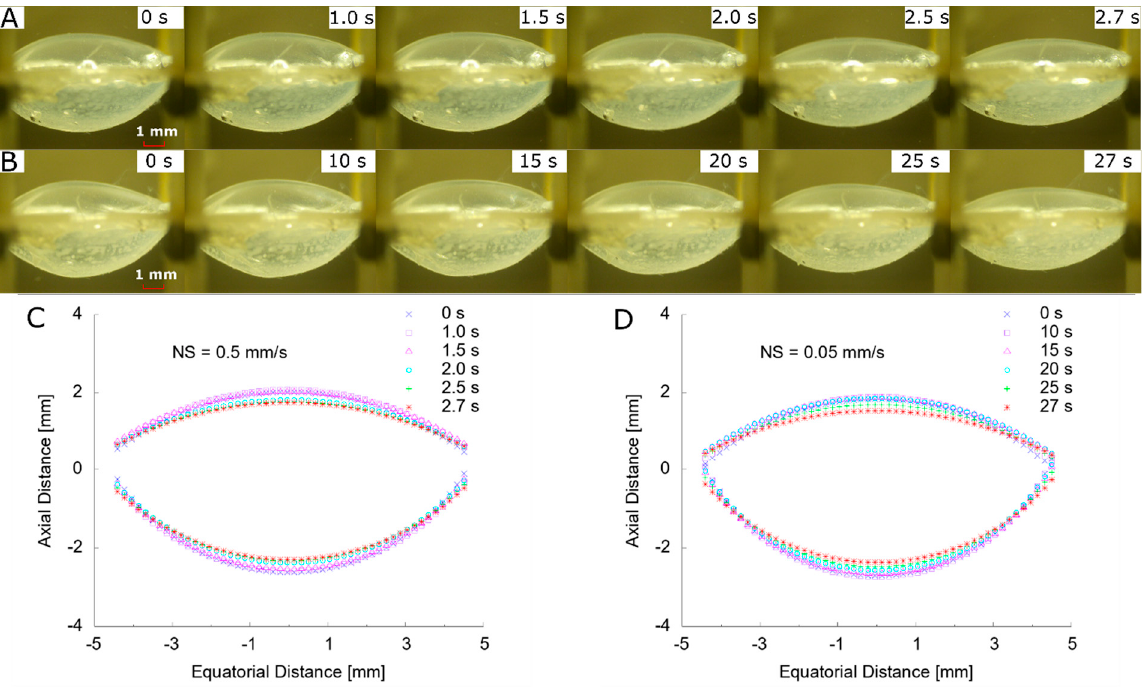
Figure 6. Stretching process from side view: ( A ) evolution of profile at NS = 0.5 mm/s; ( B ) evolution of profile at NS = 0.05 mm/s; ( C ) fitted profile at NS = 0.5 mm/s; ( D ) fitted profile at NS = 0.05 mm/s.